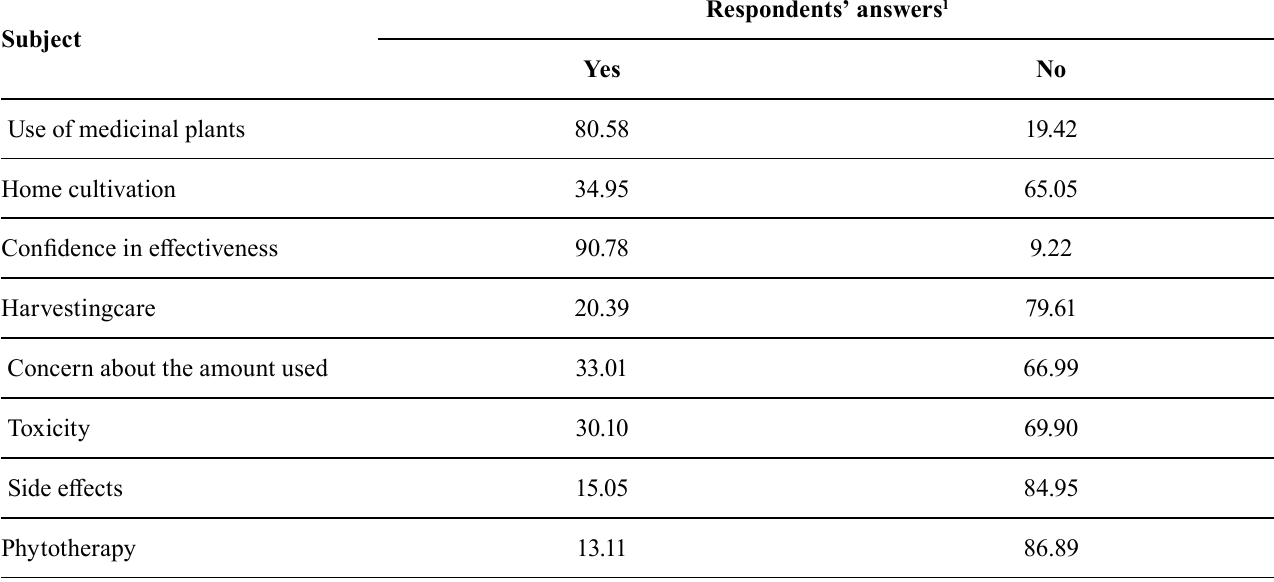
TABLE I – M ean knowledge and attitude scores toward use of medicinal plants of students and their associated community